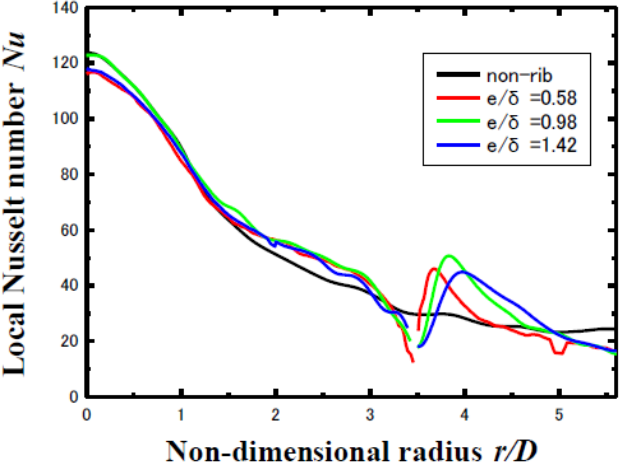
Figure 5. Effect of circular rib height on the local Nu at r / D = 3.5.